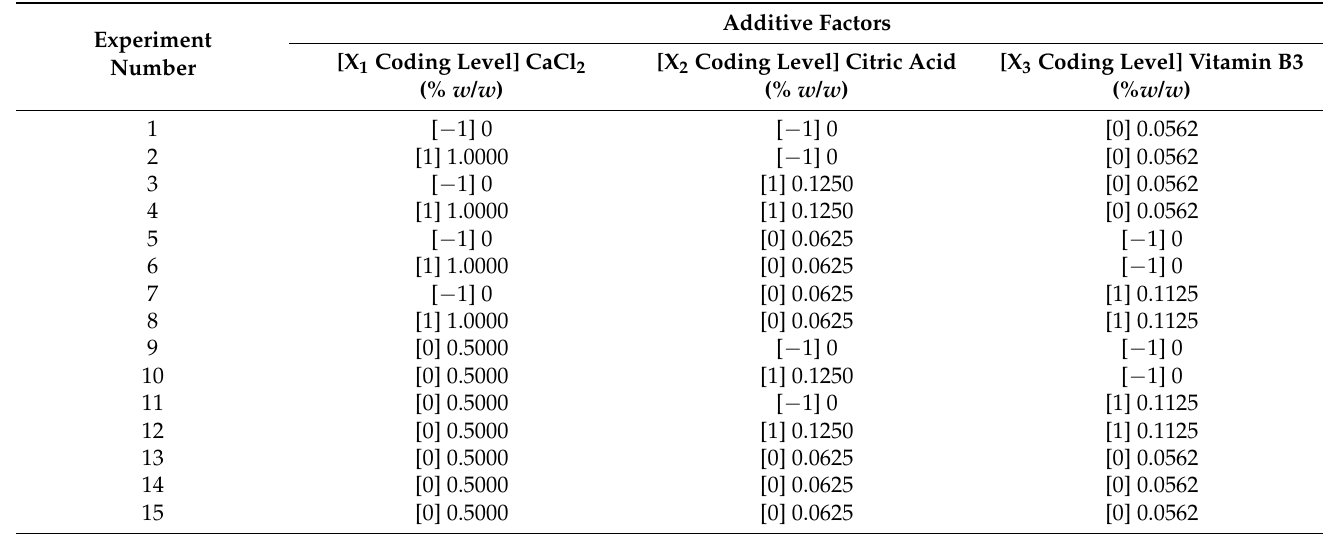
Table 1. Box–Behnken design to evaluate combinations of additives affecting the formation of acrylamide and HMF in thick simulated cane juice heated to 120 °C for 30 min.